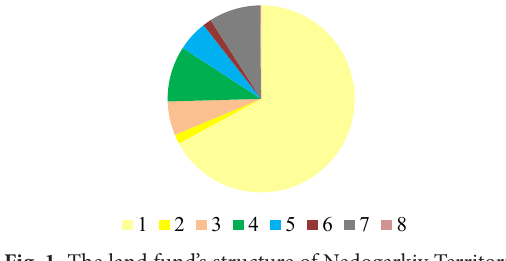
Fig. 1. The land fund’s structure of Nedogarkiv Territorial